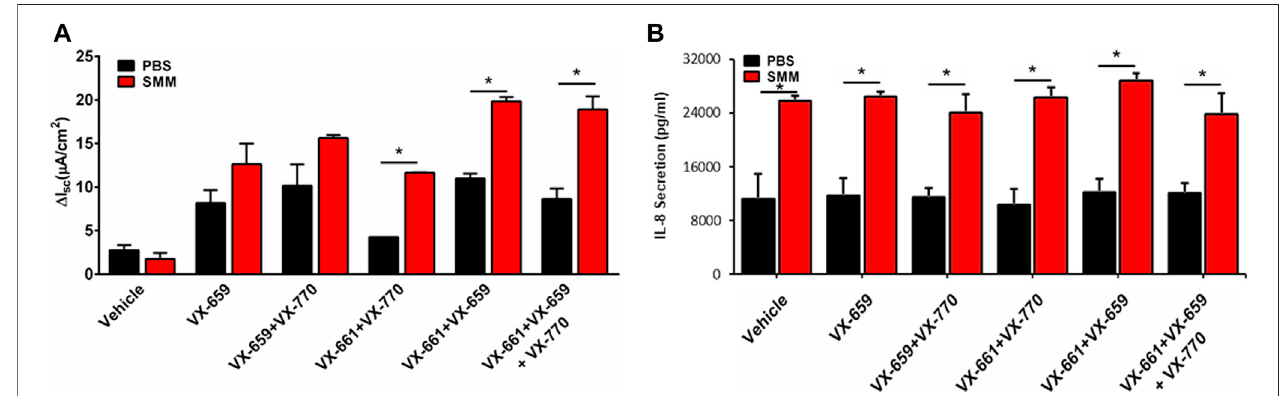
FIGURE 4 | SMM enhances triple combination-promoted F508del rescue. (A) CFTR responses to acute forskolin + VX-770 from F508del/F508del HBE in Ussing chambers. HBE were treated with VX-659 (1 µM), VX-661 (5 µM) and VX-770 (5 µM). (B) IL-8 secretion from the CF HBE cultures evaluated in A . Dataare expressed as mean ± SEM. * p < 0.05; n (cid:2) 2 donors, fi ve to six cultures/experimental